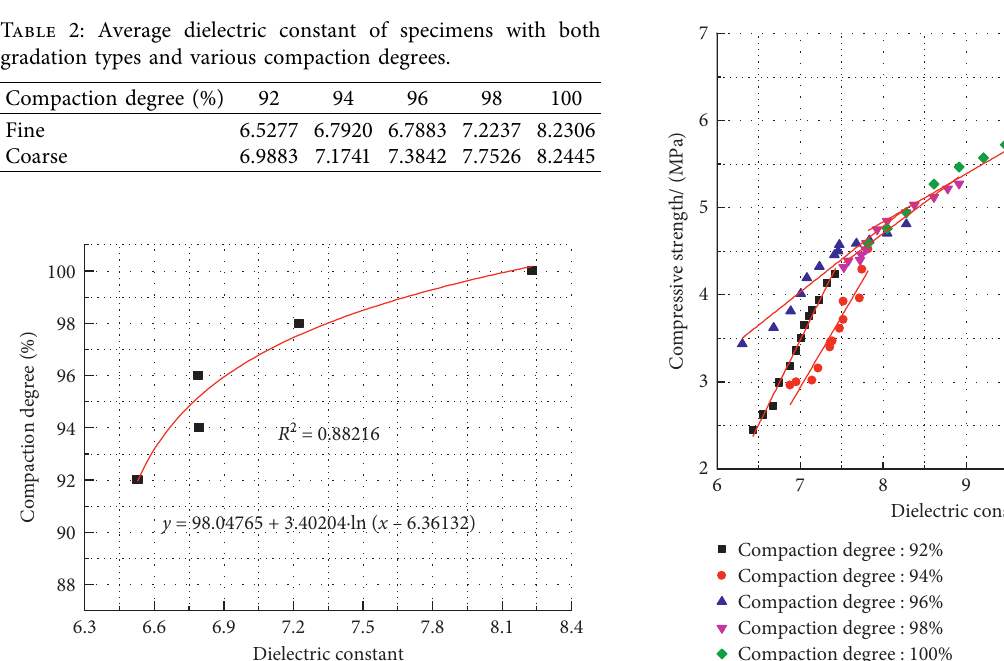
Figure 4: Relationship between the compaction degree and the dielectric constant of fine specimens.